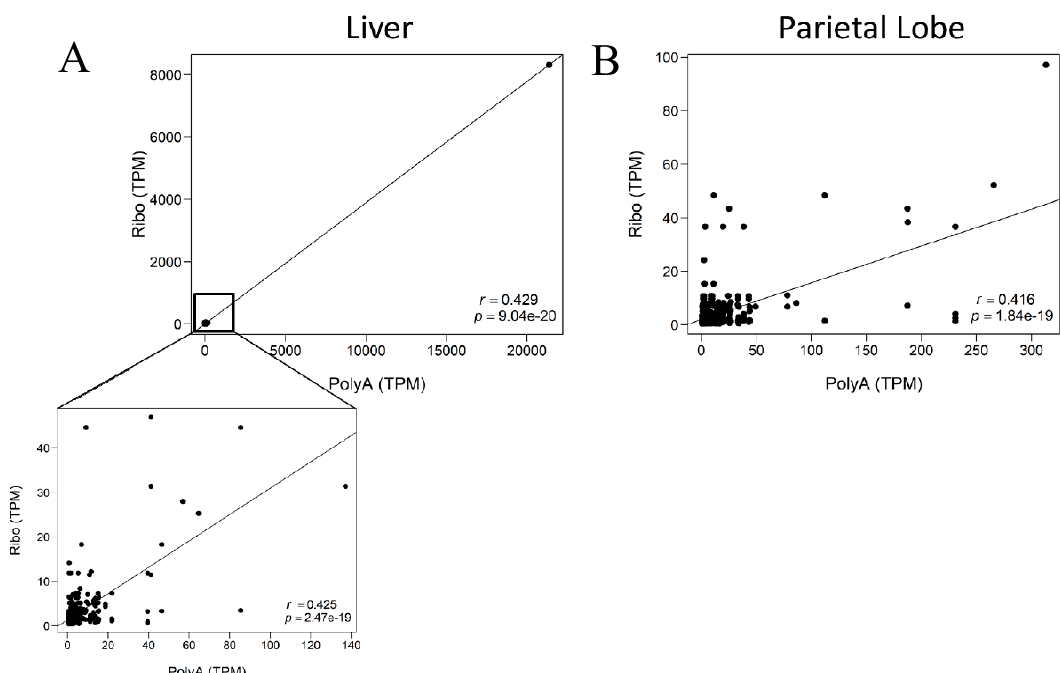
Figure 5. Correlation plots for lncRNA expression in AH1 with RefSeq annotated lncRNA. The x-axis indicates expression of the individual lncRNA in the poly-A + selected library. The y-axis shows expression of the same lncRNAs in the rRNA-depleted library. ( A ) Liver ( B ) Parietal lobe of the cerebrum. Spearman correlation (r) and p -value in bottom right corner.